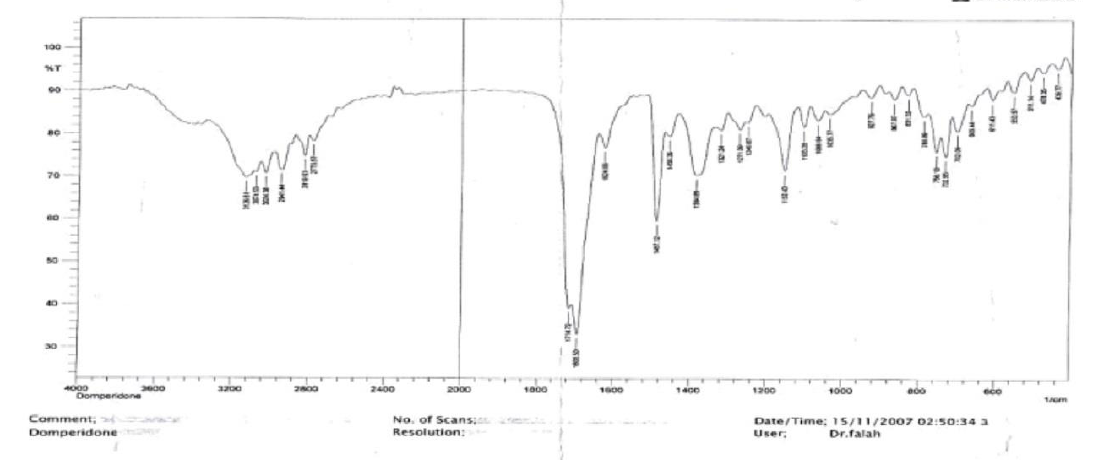
respectively. As well as aromatic symmetric and asymmetric C ̶ H stretching bands appeared at 3024 and 3074 cm -1 respectively, and the aromatic C = C stretching band appeared at 1624 cm -1(22) as shown in figure (12). The resulted FTIR of PVP- K15, the physical mixtures of PVP-K15:pure domperidone (2:1) and F8 as in figures (13, 14 and 15) showed the presence of main peaks of which indicates there polymer during preparation of nanoparticles.